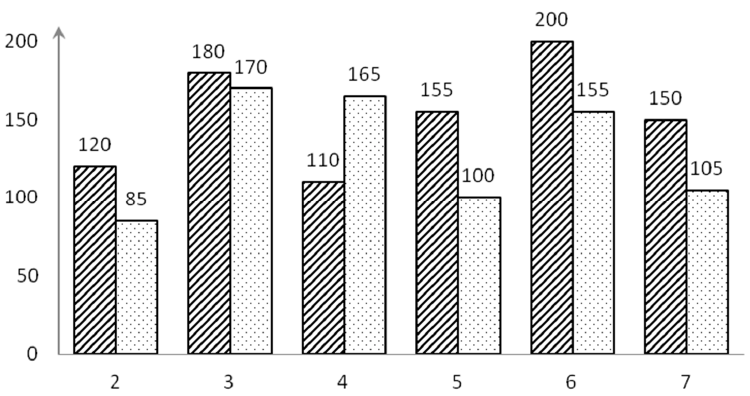
Figure 9. Fluidity of the mortar: diagonal stripes denote initial mortar fluidity and dots denote mortar fluidity after 1 h plus 40 min.